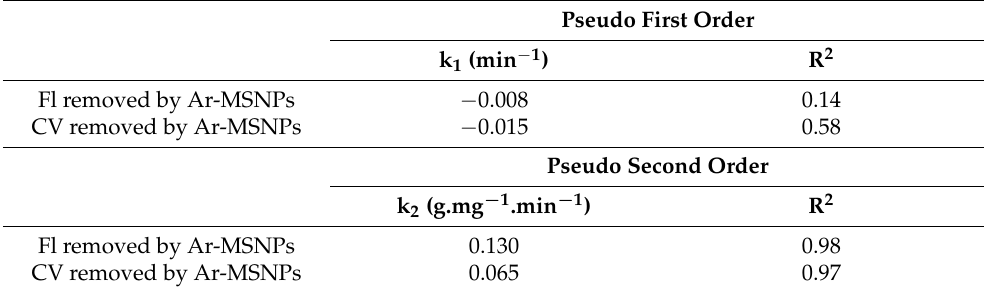
Table 4. Pseudo first-order and pseudo second-order parameters for the adsorption process at 298